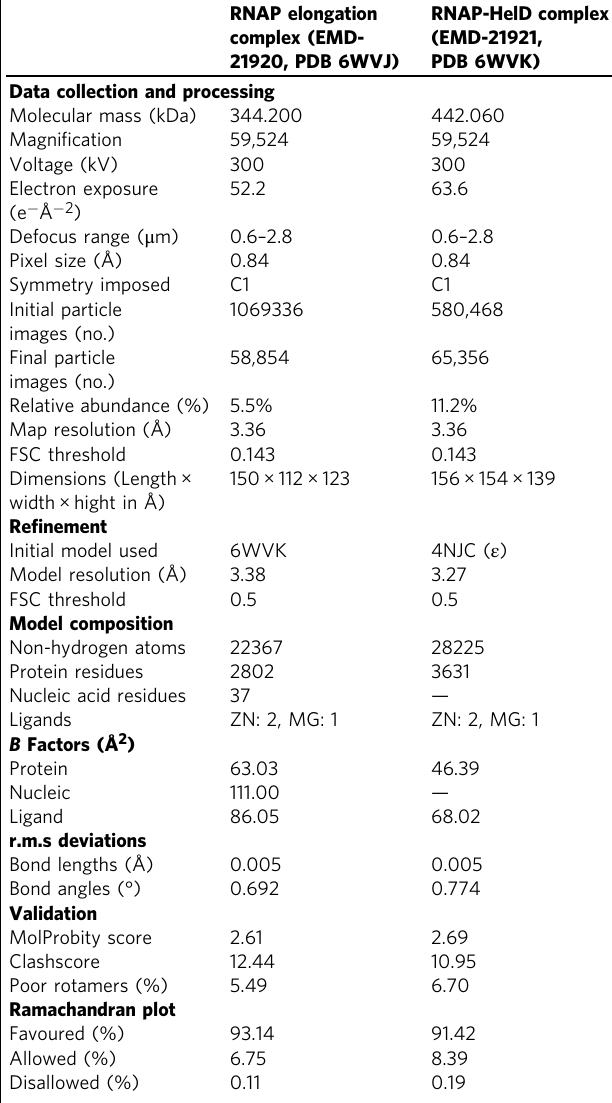
Table 1 Cryo-EM data collection, re fi nement and validation statistics. RNAP elongation complex